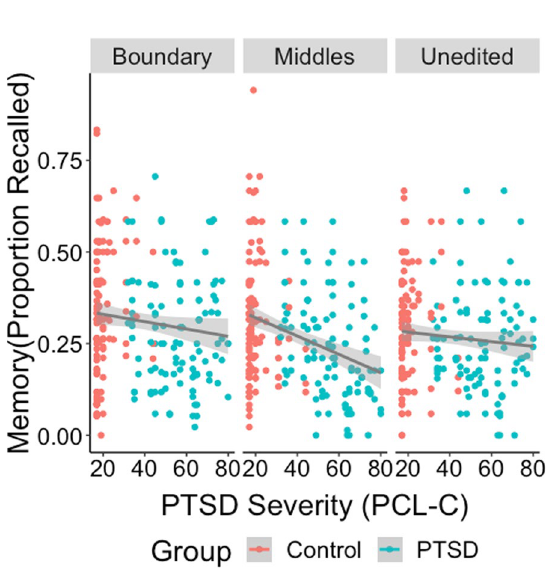
Fig. 3 Recall probability as a function of PTSD symptom severity and cueing